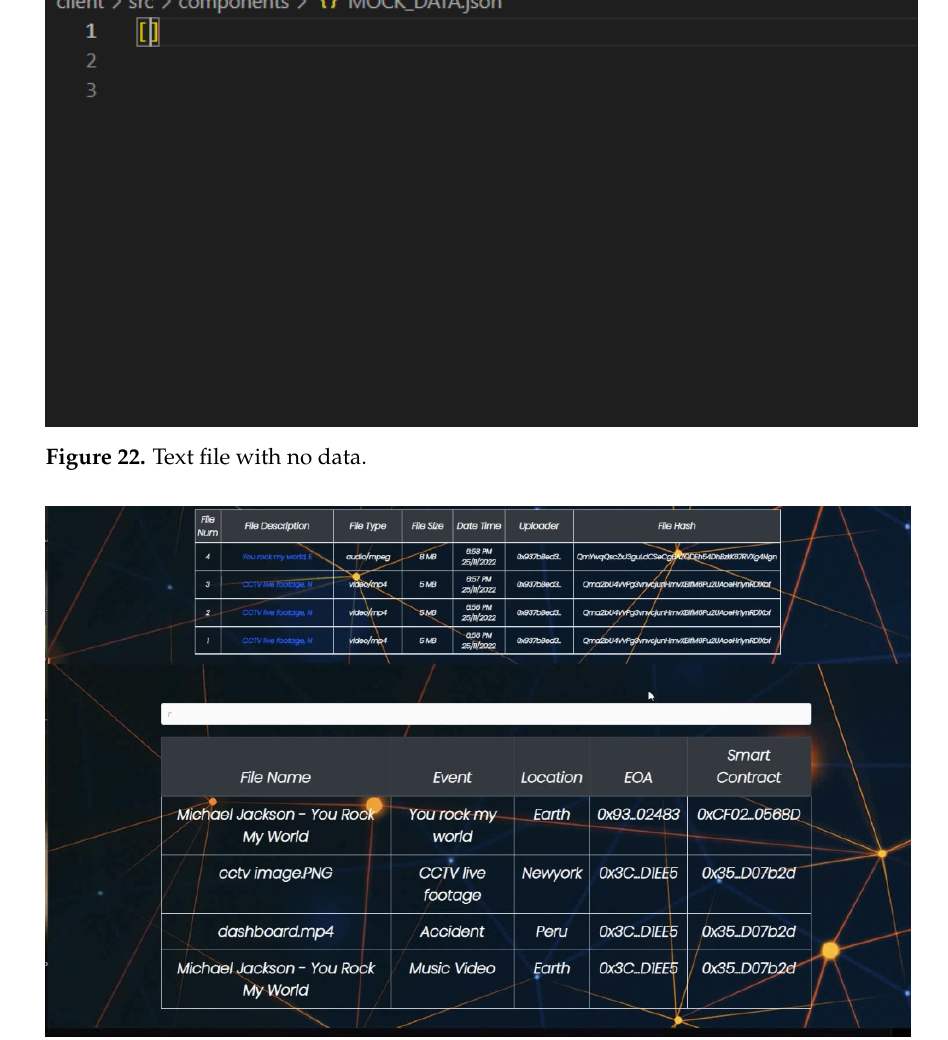
Figure 23. Keyword